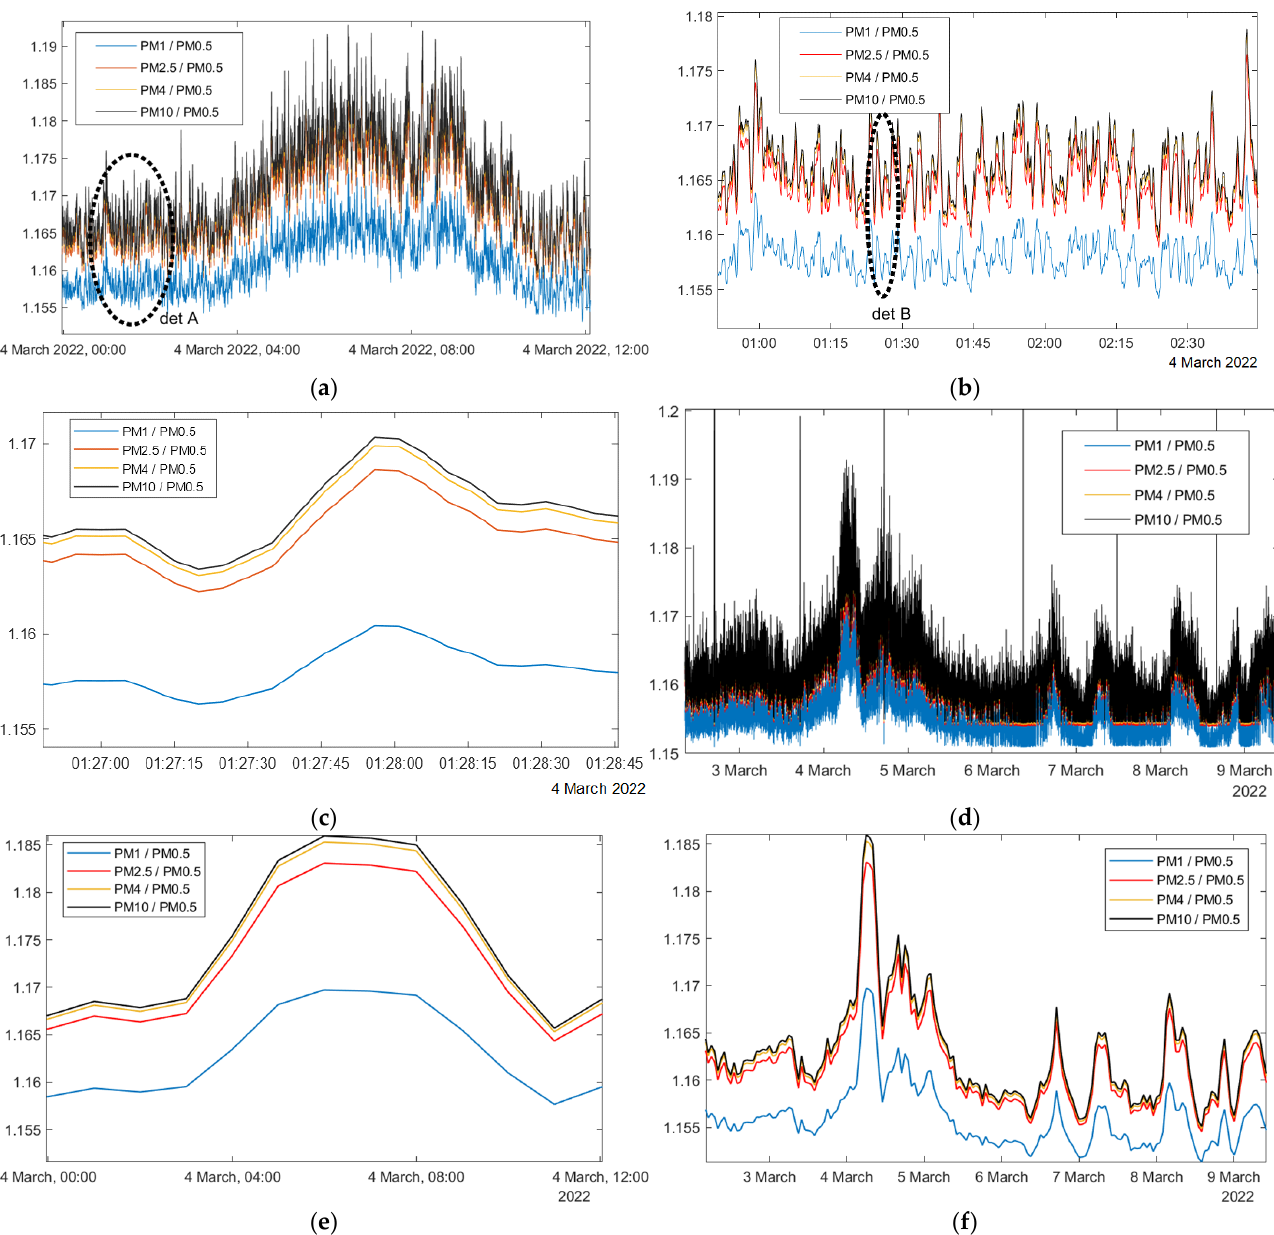
Figure 7. Illustration of the changes in the ratios of PM1, PM2.5, PM4, and PM10 vs NC PM0.5 of the measured PM number concentrations at DTIEE 4 March 2022 from 0:00 to 12:00 h for: ( a ) 5 s intervals, ( b ) close-up detail (det A) from Figure 7a, ( c ) close-up detail (det B) from Figure 7b, ( d ) 5 s intervals from 2–9 March 2022, and hourly averages ( e ) over the 12 h of measurement, ( f ) over several days of measurement (from 2–9 March 2022).